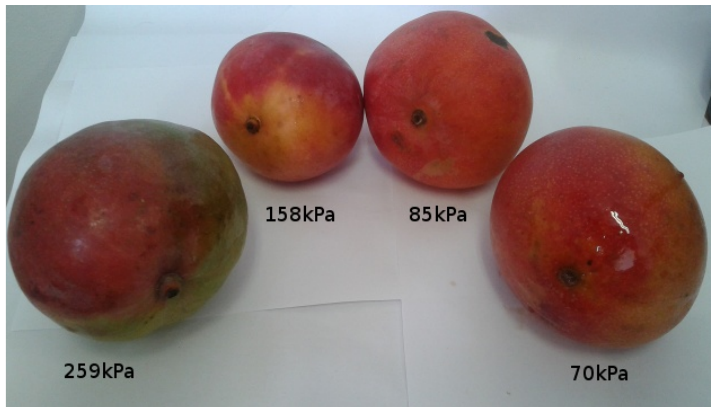
Figure 13. Turgor pressure in Kilo-Pascal (kPa) measured with the glove for mango. The fruit on the left is more unripe and the one on the right is more